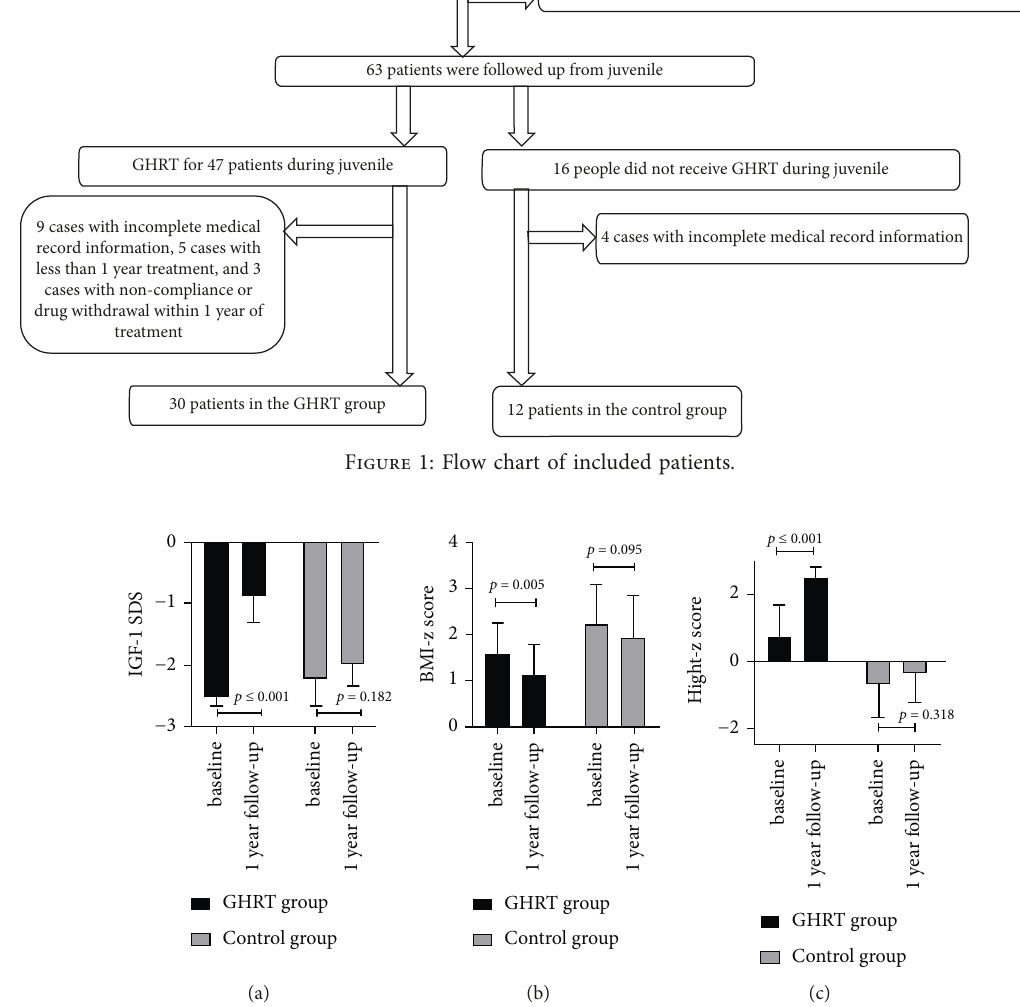
Figure 2: Change of IGF-1SDS, BMI z-score, height z-score in the GHRT group and control group.